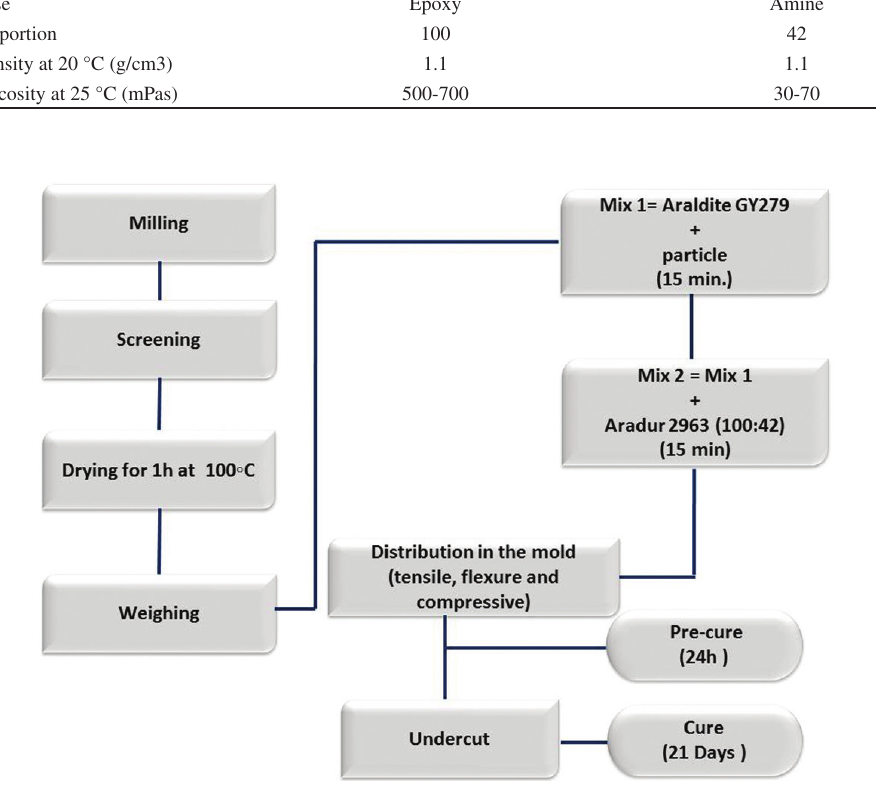
Figure 1. Flow diagram for the preparation of the particulate